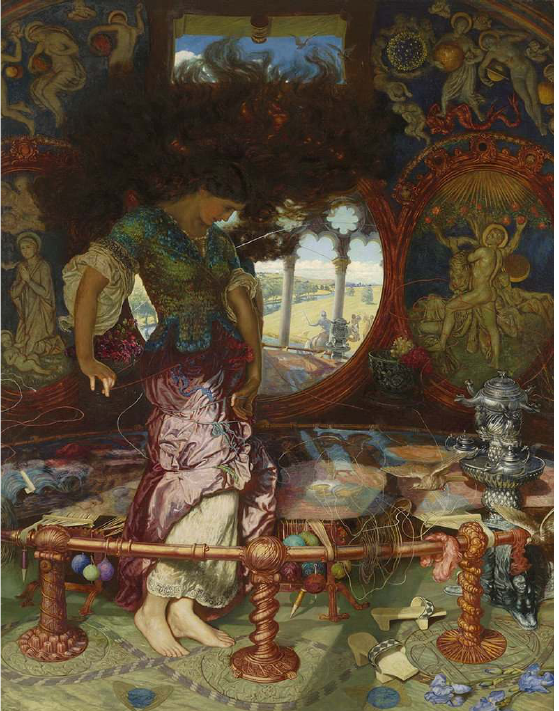
Figure 1: William Holman Hunt, The Lady of Shalott